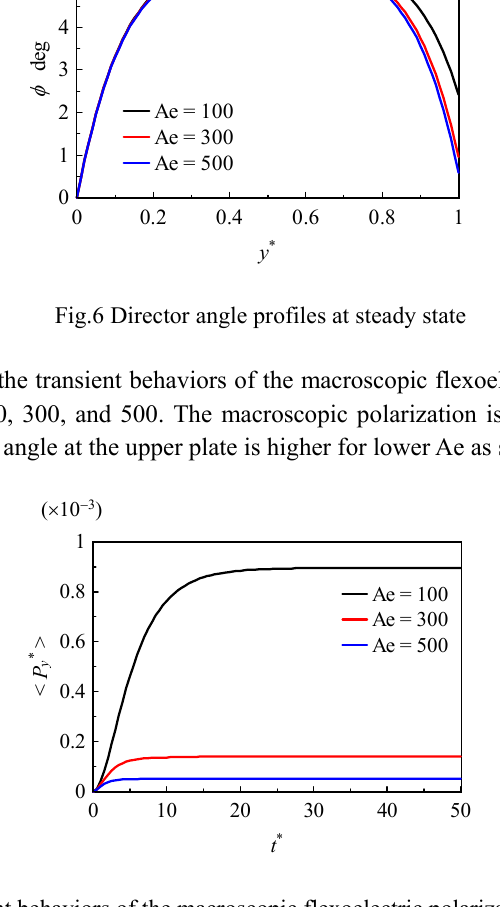
Fig.7 Transient behaviors of the macroscopic flexoelectric polarization for